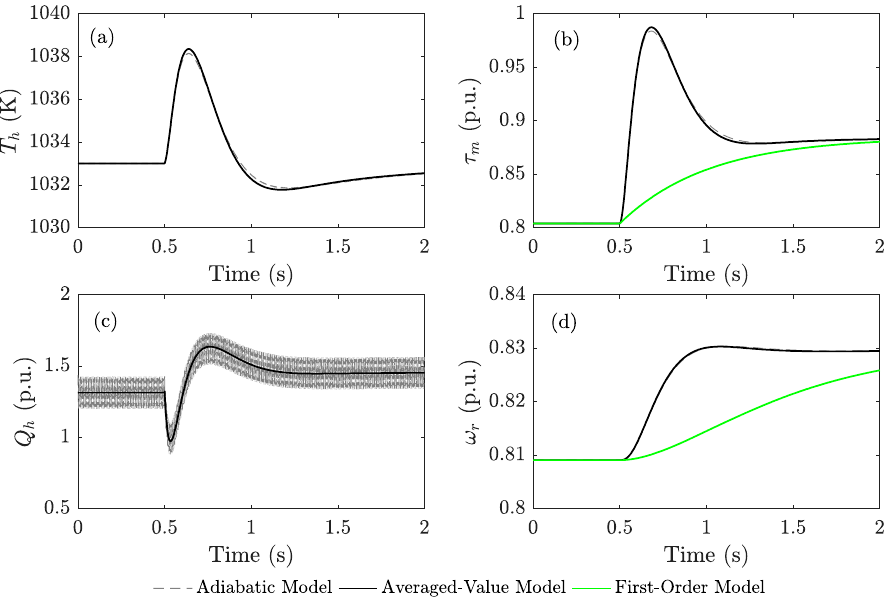
Figure 10. Comparison of simulation results with different Stirling engine model in response to a step change of insolation: ( a ) receiver temperature, ( b ) mechanical torque of the Stirling engine, ( c ) absorbed heat transfer rate of the Stirling engine, and ( d ) rotational speed of the DFIG.